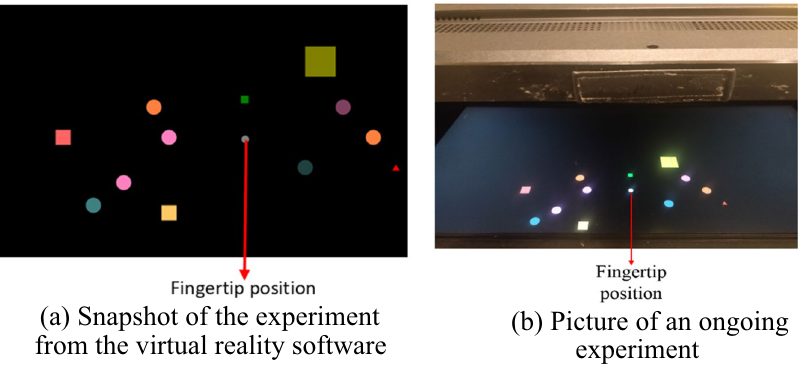
(b) Picture of an ongoing experiment